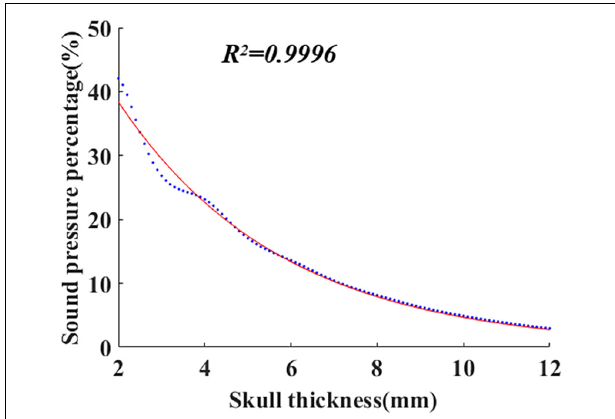
FIGURE 1 | The peak sound pressure percentage fitting curve with skull thickness.